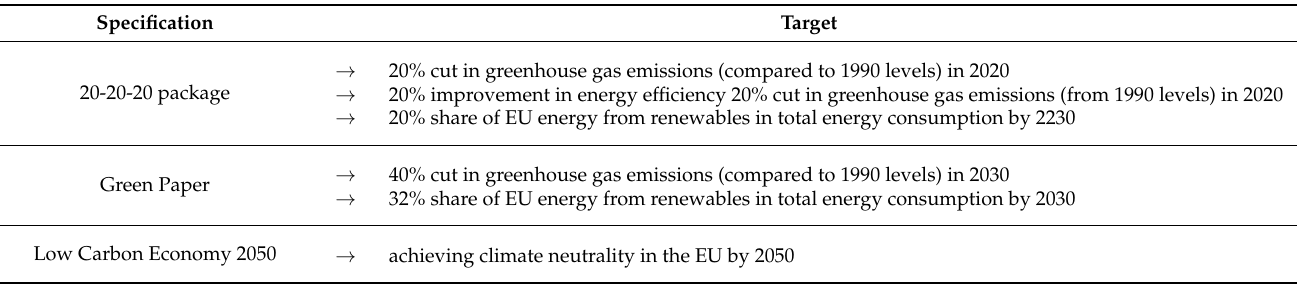
Table 2. Energy policy targets in the European